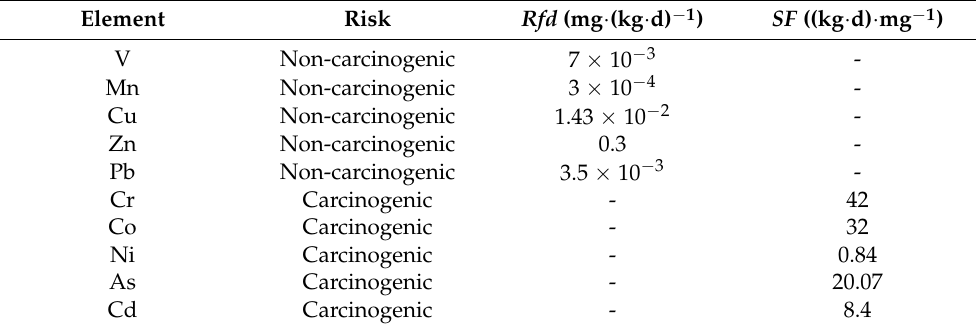
Table 3. Response parameters of elements entering through the respiratory system